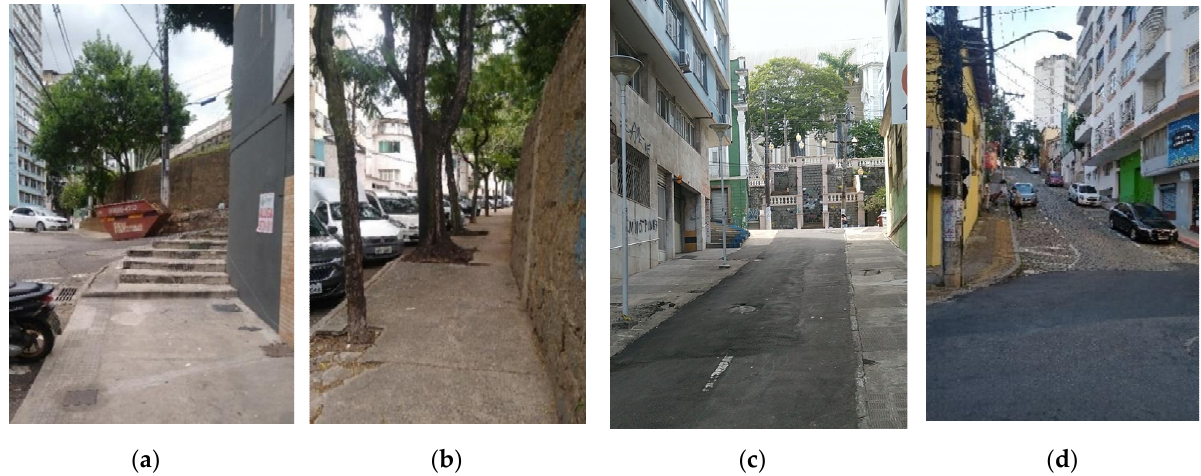
Figure 11. Examples of stretches with the worst classifications, and thus spaces unfriendly to older adults according to the application of the WIEH ( a ) Rua Dionísio Rosendo, with stairway at the inflection angle; ( b ) Rua Dionísio Rosendo, with narrowing of the passage and uneven floor, heightening the risk of falls; ( c ) Rua Cerqueira Lima, the only shared street in the study area, presents a steep slope and several potholes; in the background, the access stairway to the Cathedral, through Dionísio Rosendo Street; ( d ) Rua Prof. Baltazar, with an incline greater than 10%, and which also provides access to the